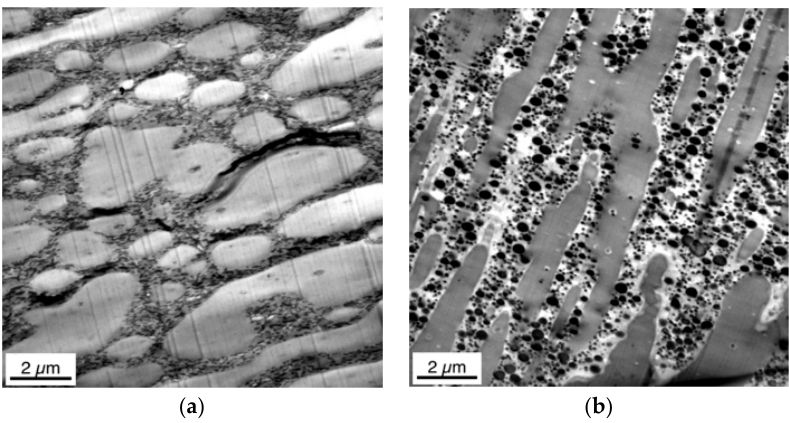
Figure 6. TEM micrographs of compounded pellets of PC/ABS blend with SAN medium. ( a , b ) cuts with different orientations relative towards the strand extrusion direction.